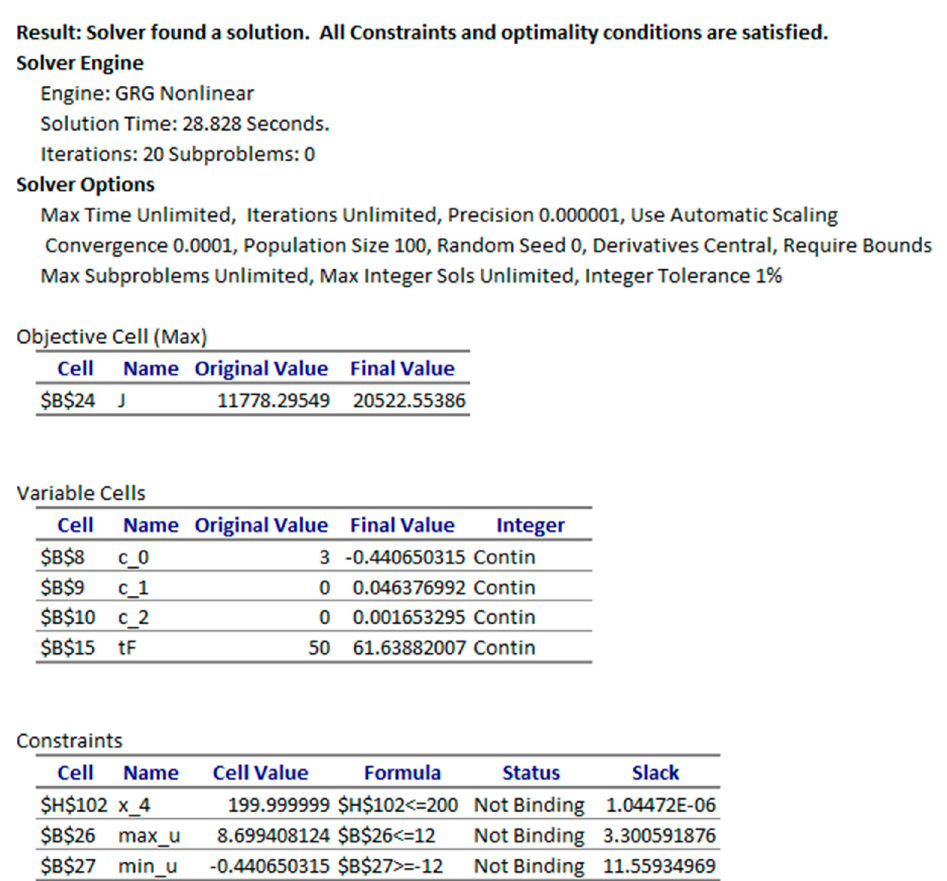
Figure 22 . Answer report generated by Excel solver for problem 3.4. Figure 22. Answer report generated by Excel solver for problem